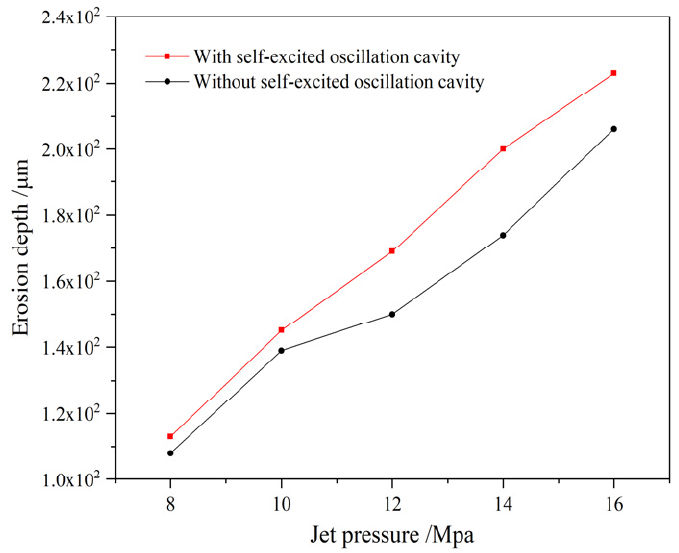
Figure 13. Erosion depth influence curve under different jet pressures.